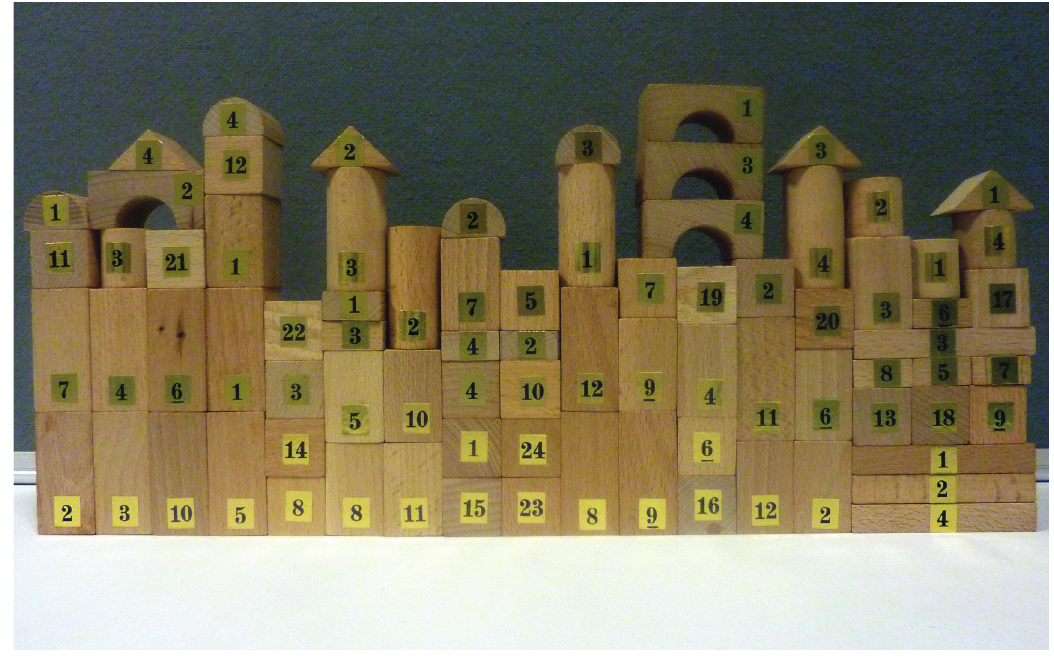
Figure 1. Collective goal.